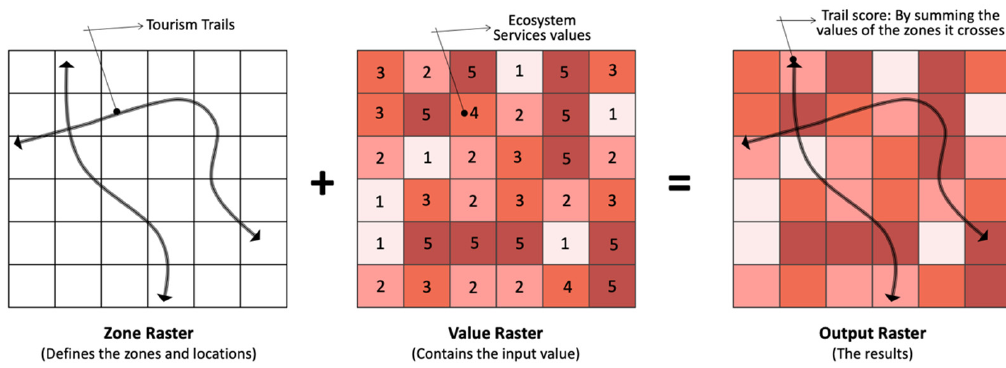
Figure 5. Zonal Statistics Tool concept. Source: based on [52] by researcher.